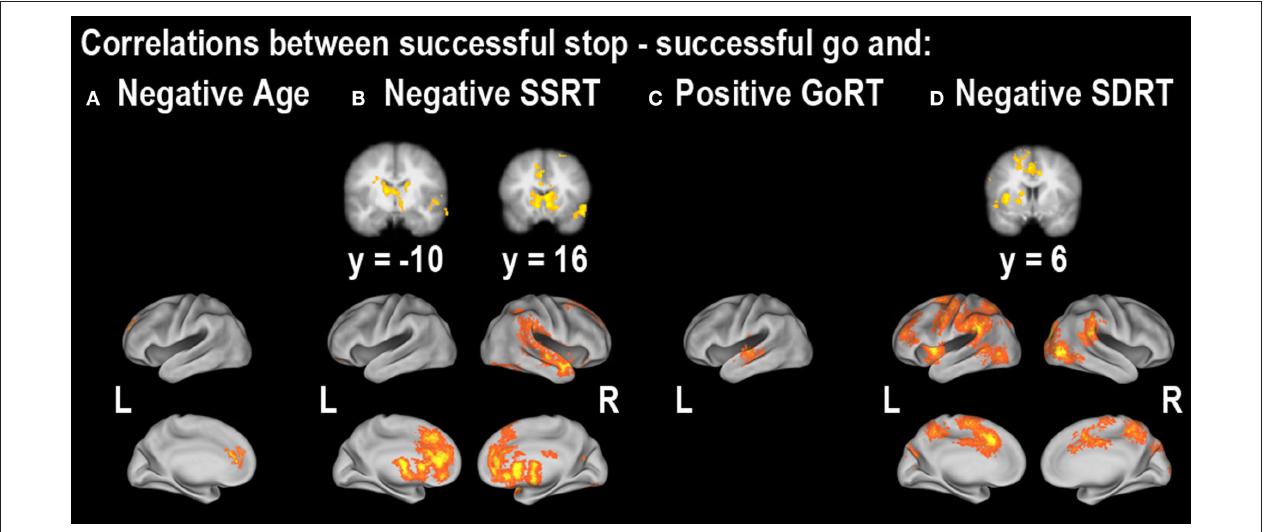
FIguRe 5 | Regions showing correlations between successful stopping vs. successful going and (A) age, (B) SSRT, (C) median Go response time (GoRT) and (D) the standard deviation of Go response time (SDRT). All correlations were corrected at the whole-brain level at z > 2.3, p < 0.05. For cluster details, see Table 4 .